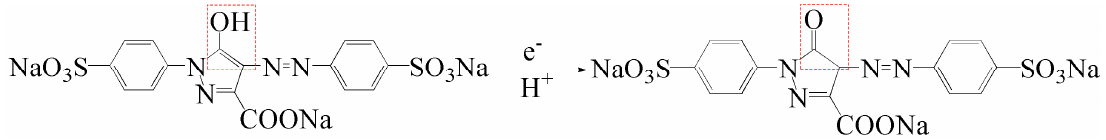
Figure 7. The mechanism of the electrochemical oxidation of tartrazine on the TiO 2 –ErGO–GCE.